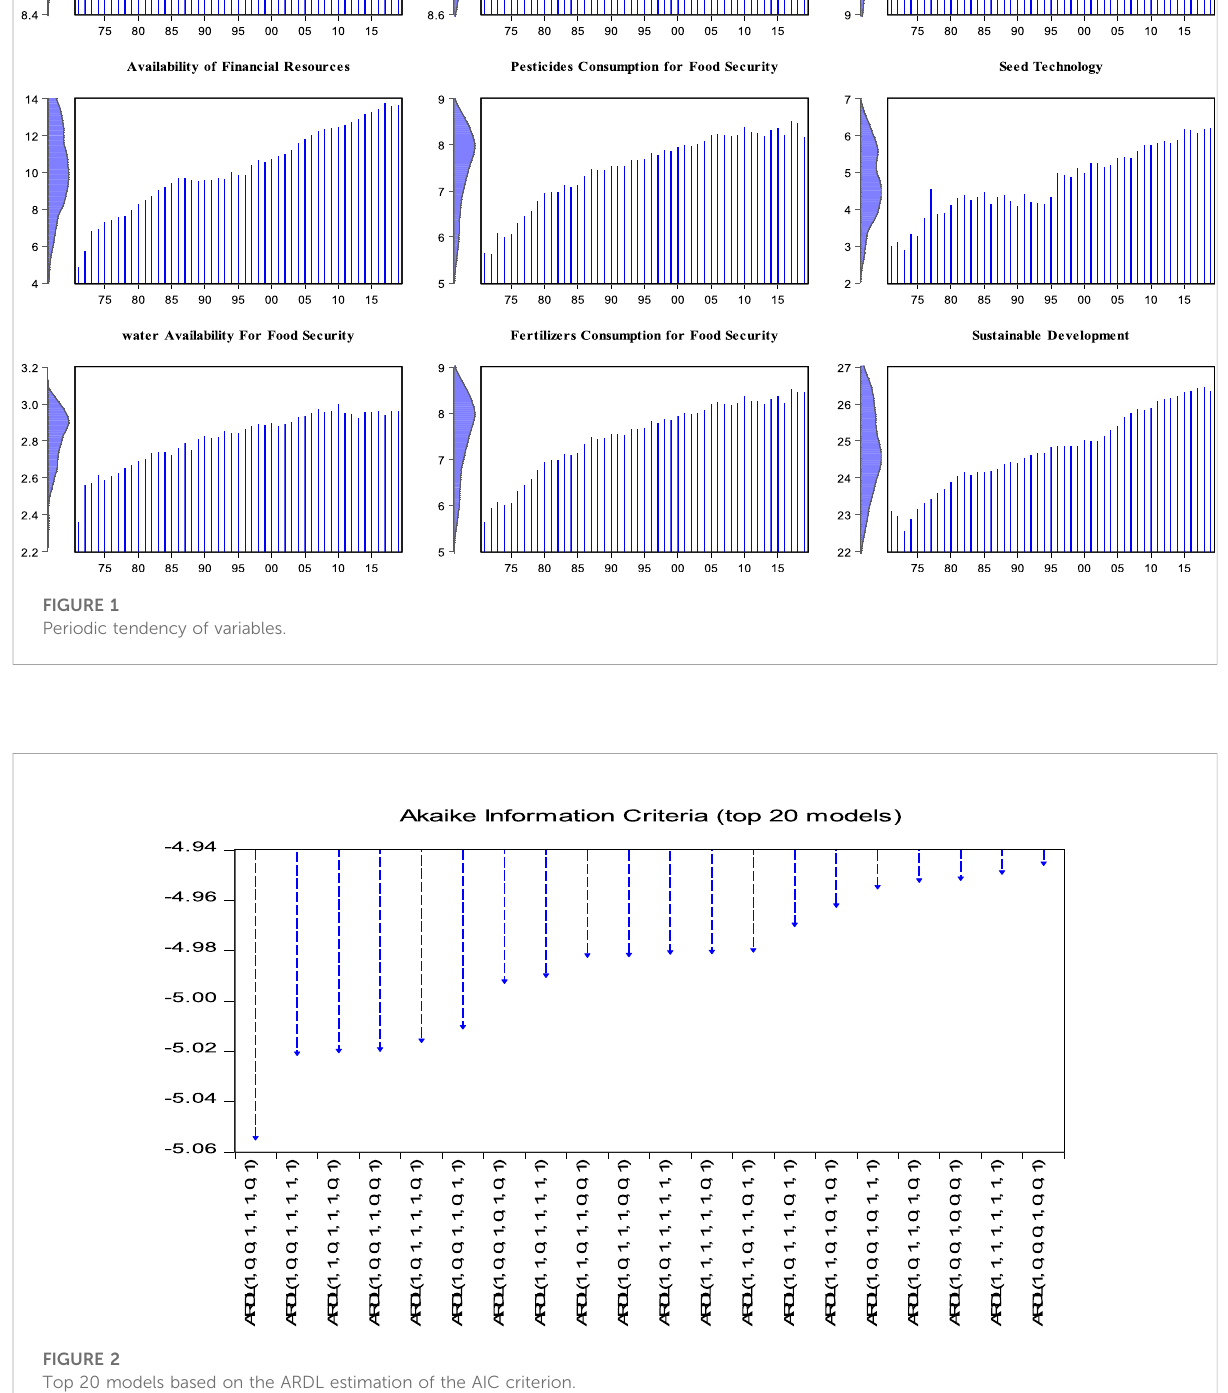
FIGURE 2 Top 20 models based on the ARDL estimation of the AIC criterion.